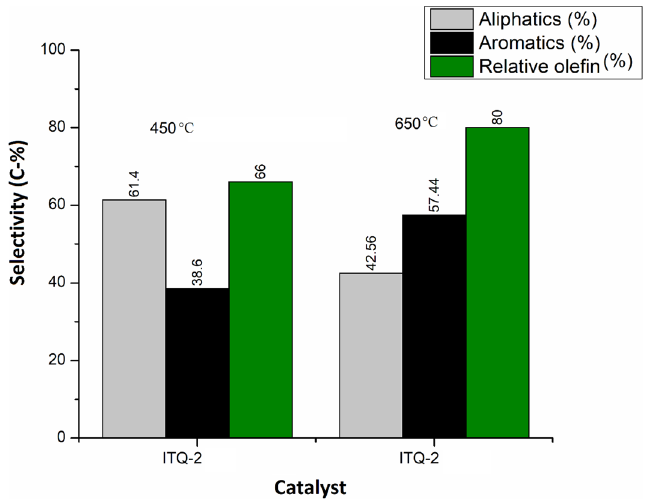
Figure 8. Comparison of aliphatic, aromatic and olefin selectivity over ITQ-2 zeolite at 450 °C and 650 °C.